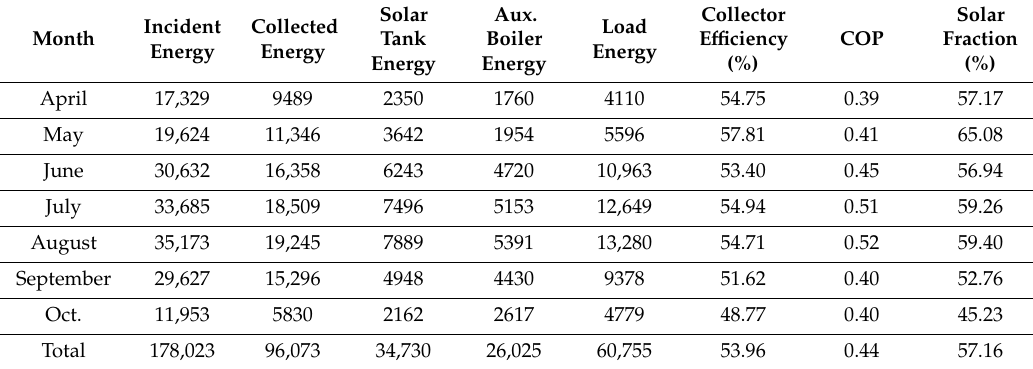
Table 5. Most relevant data and results for the cooling season operation (kWh).